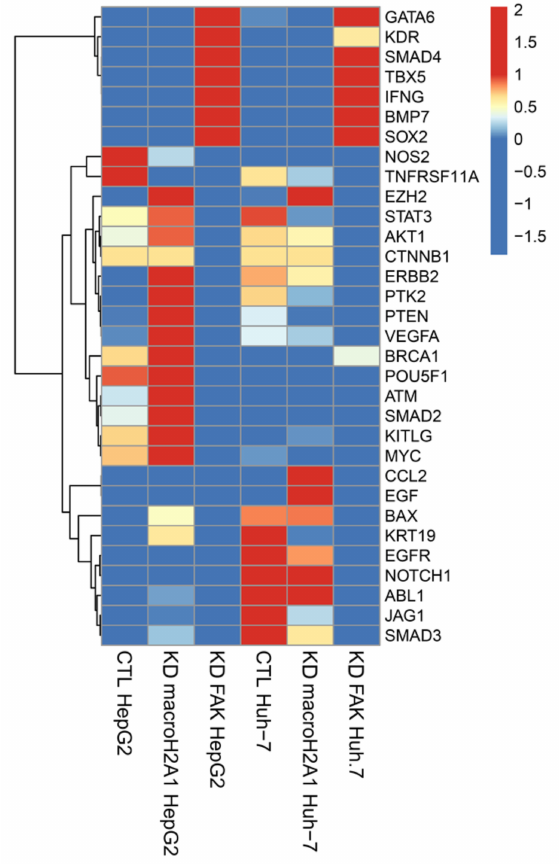
Figure 1. Di ff erentially expressed genes related to reprogramming and cancer stemness in control (CTL), macroH2A1 knockdown (KD), and FAK KD cells (Huh-7 and HepG2). Heatmap of standardized counts per million (cpm) values of reprogramming and cancer stemness-related genes in macroH2A1KD versus CTL and KAD KD versus CTL, in Huh-7 cells (left) and in HepG2 cells (right). We found that macroH2A1 KD HepG2 cells, but not FAK KD HepG2 cells, displayed